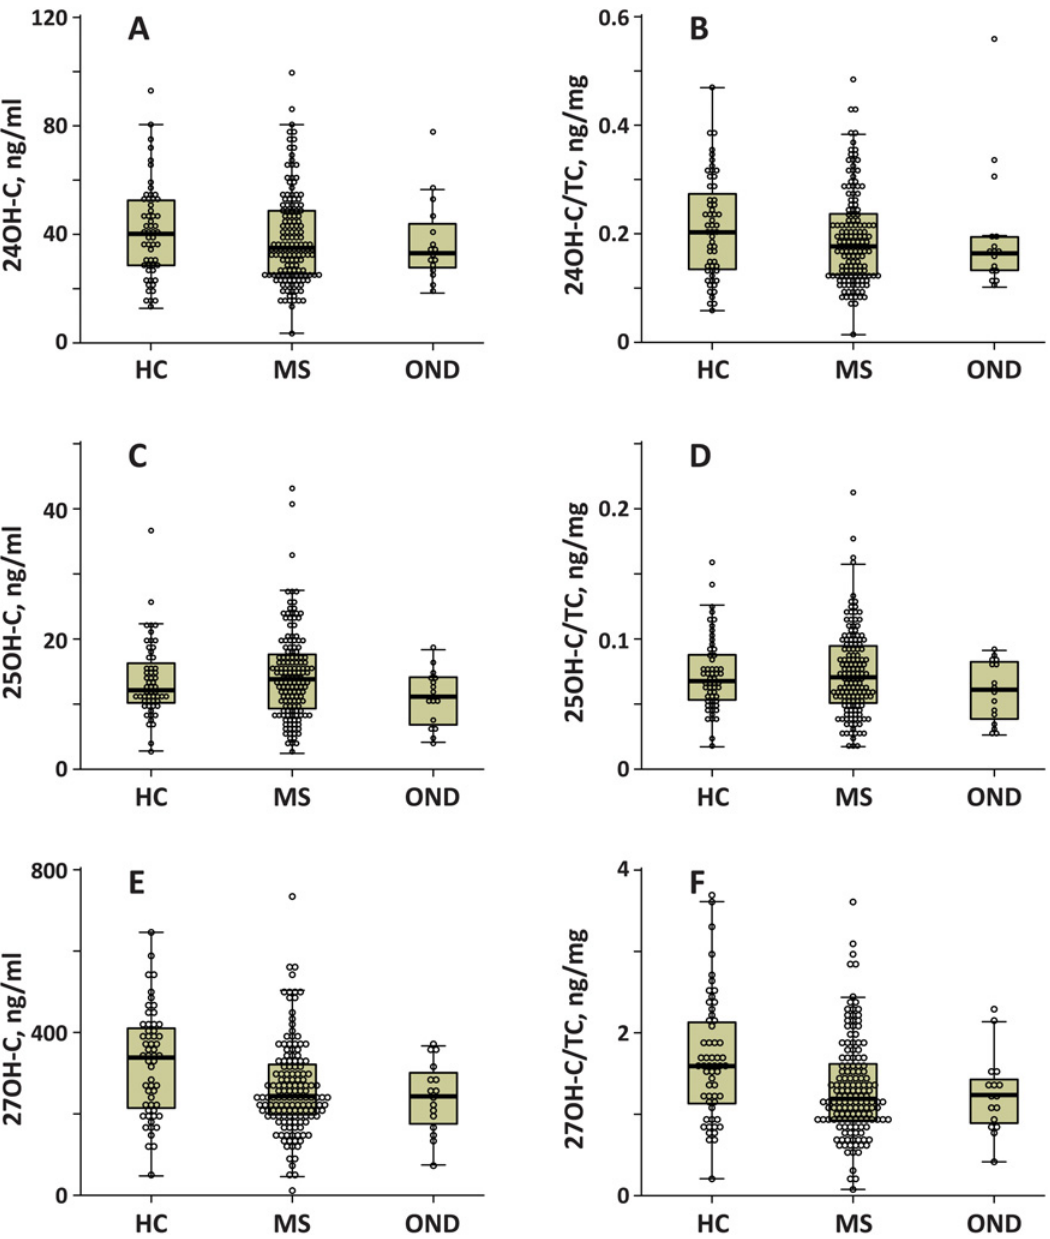
Fig 2. Side-chain oxygenated oxysterol levels in patient groups. Distribution of 24-hydroxy cholesterol (24HC; Fig 2A), 25-hydroxy cholesterol (25HC; Fig 2C) and 27-hydroxy cholesterol (27HC; Fig 2E) for healthy controls (HC), multiple sclerosis (MSC) and other neurological diseases (OND). The results in Fig 2B, 2D and 2F correspond to the oxysterols in Fig 2A, 2C and 2E, respectively, but are normalized to total cholesterol (TC) levels. The dot-plots of individual patients are superimposed on the box plots. The solid line in the box plots are the median, the box delineates upper and lower quartiles and the error bar represents the range. Panel E for 27HC and Panel F for 27HC-TC ratio contains the p-value from the Kruskal-Wallis test in the main body. The inset contains a bar graph and p-values from follow-up Mann-Whitney